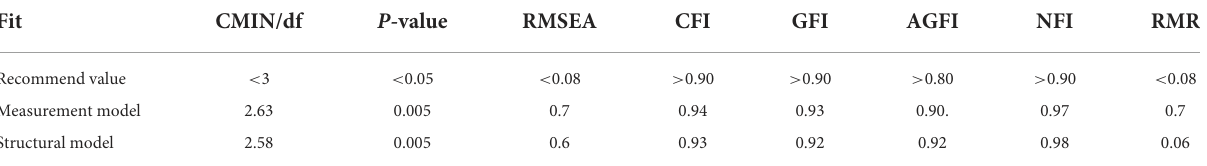
TABLE 2 Results of model